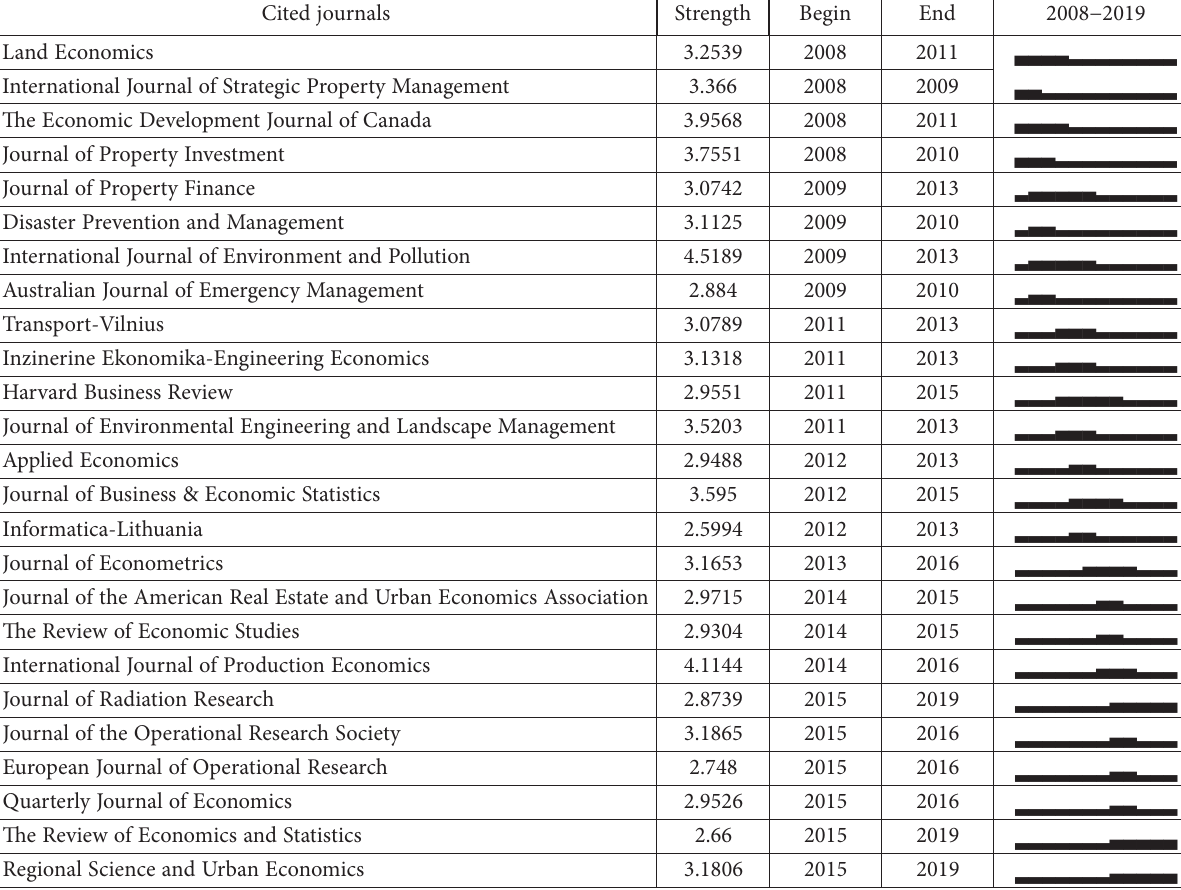
Table 9. Top 25 cited journals with the strongest citation